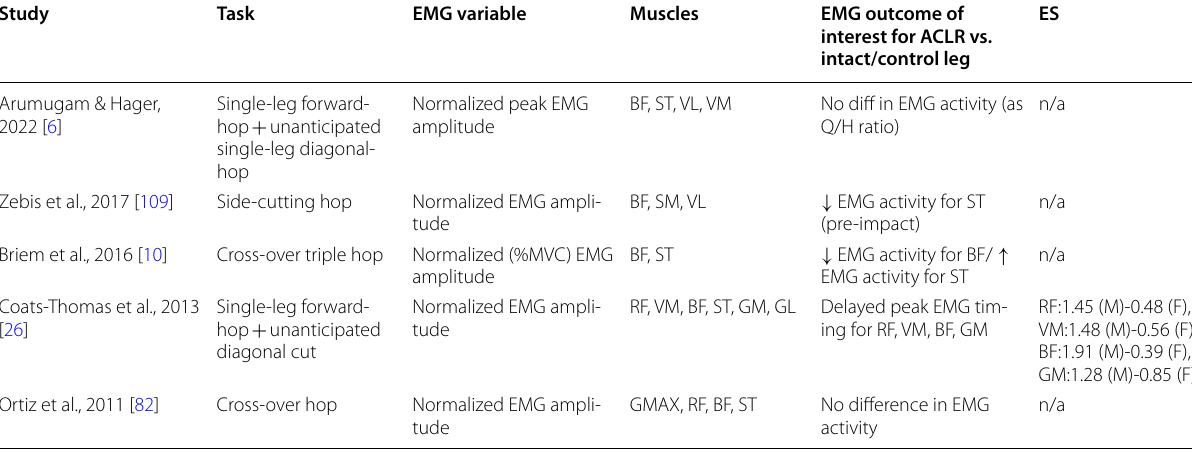
Number in brackets corresponds to reference number EMG Electromyographic, %MVC % Maximum voluntary contraction, BF Biceps femoris, ST Semitendinosus, RF Rectus femoris, VL Vastus lateralis, VM Vastus medialis, GM Gastrocnemius medial, GM Gastrocnemius lateral, Q/H ratio Quadriceps to hamstrings